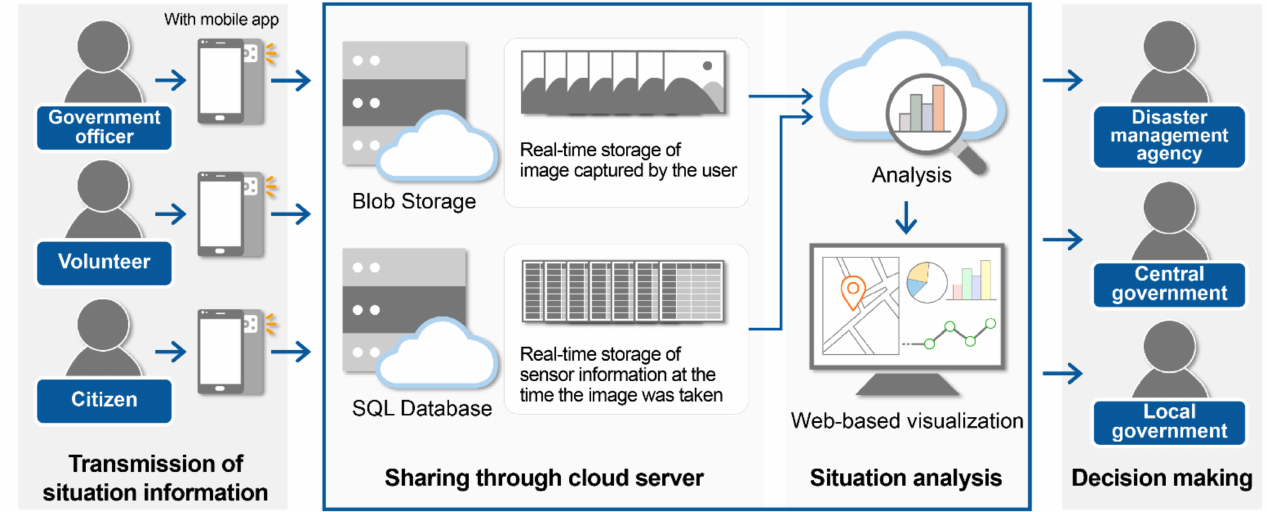
Figure 2. Cloud computing-based automatic situation awareness process using smartphone